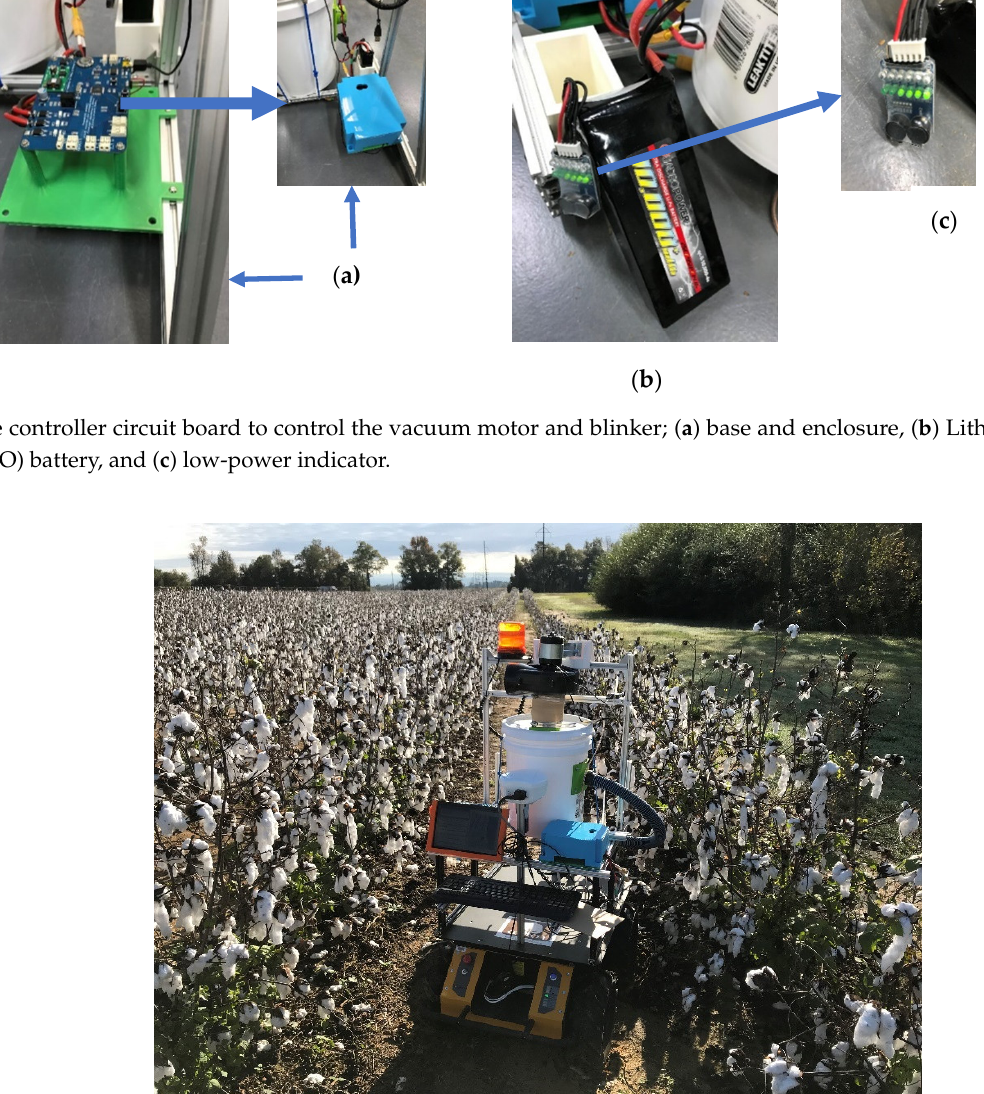
Figure 6. The mobile platform with the harvester module.